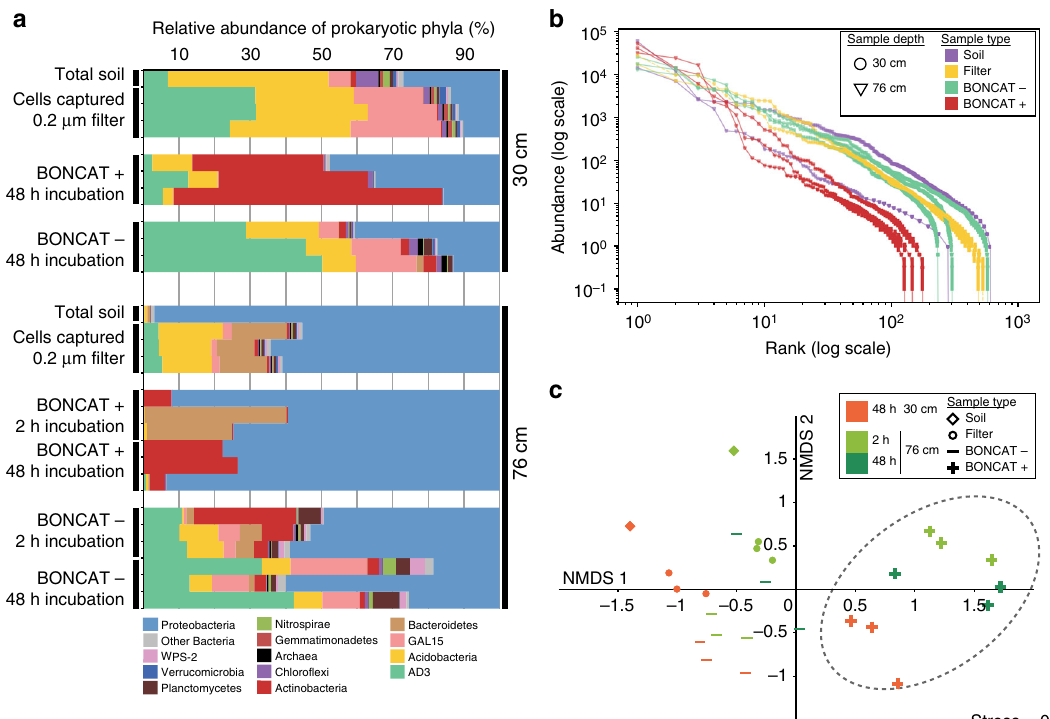
Fig. 2 Composition of total community and sorted fractions (16S rRNA gene sequencing). a Microbial diversity displayed at the phylum level for all samples analyzed. b Rank vs. abundance (absolute abundance from the rare fi ed OTU table at an even depth of 81000 sequences, see “ methods ” ) plot in log – log scale of the libraries of averaged biological replicates, standard deviations are displayed as error bars ( n = 3). c NMDS ordination of the Bray Curtis pairwise distance of all libraries. 95% con fi dence ellipse is displayed on the BONCAT + group of samples. “ Bulk Soil ” samples are libraries constructed from total DNA extracted from soil, “ Filter ” samples are DNA extracted from all cells detached from soil and captured on a 0.2 µ m fi lter, BONCAT + and BONCAT − libraries were constructed from corresponding cell sorted